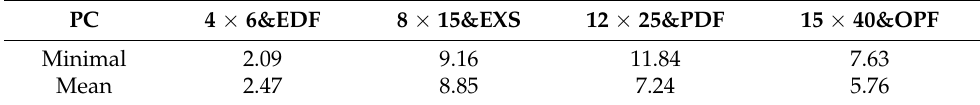
Table 11. rpd s (%) of the objective consideration